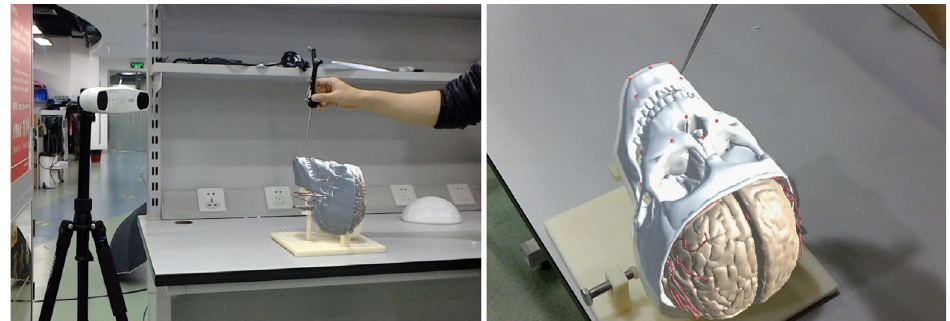
Fig. 6 Automatic registration accuracy validation; red points are